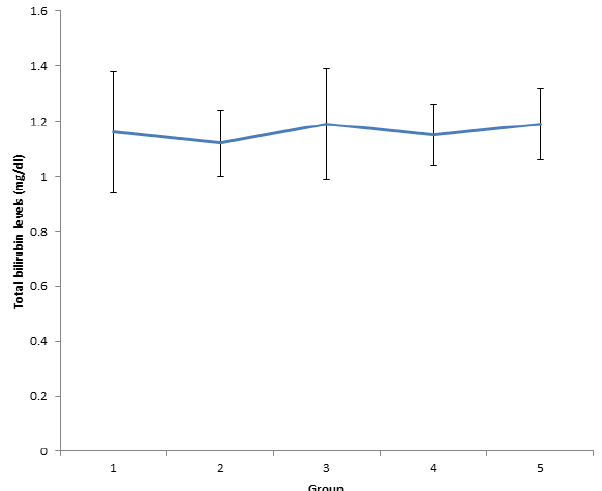
Fig. 1. Effects of administration of graded concentrations of quail egg on total bilirubin levels of alloxanized